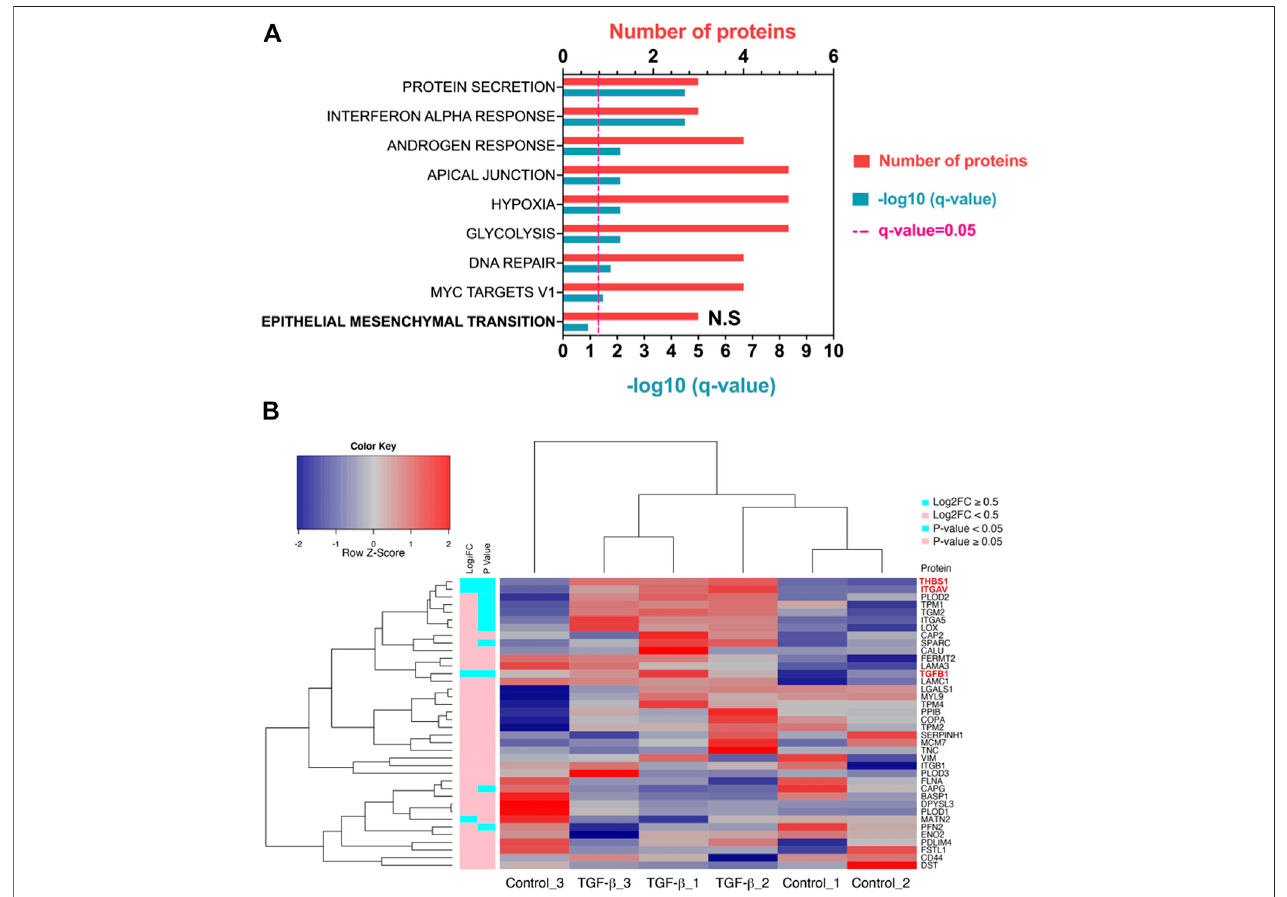
FIGURE 2 | TGF- β in ATII cells does not induce a classical EMT program at a given time point. (A) Pathway analysis in Metascape (Metascape.com) analyzing differentially expressed proteins (DEPs) in ATII ER:KRASV12 cells treated with 5 ng/ml TGF- β or control for 24 h, all non-signi fi cant pathways have been removed from the diagram with the exception of epithelial-mesenchymal transition (EMT) which was not signi fi cant and has been highlighted in bold. (B) Heatmap and hierarchical cluster analysisofATII ER:KRASV12 cellstreatedwith5 ng/mlTGF- β orcontroltreatedfor24h,apanelofhallmarkEMTproteinswereevaluated. p Value(blue: p Value < 0.05,